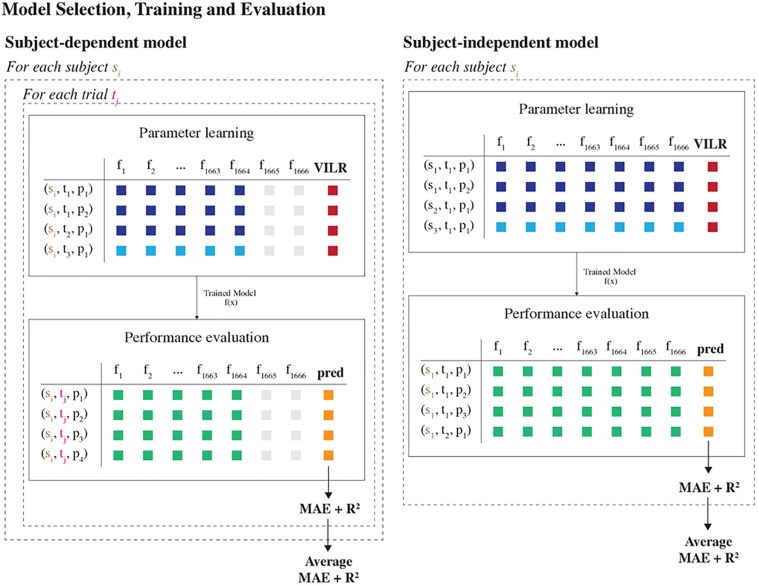
Model selection, training and evaluation part of the machine learning pipeline. Two different learning settings were considered, differing in how the data were split into training and test sets. In the subject-dependent setting, we trained a model on the data of one specific runner, including all trials except one. Subsequently, the model was evaluated on the data of the one held-aside trial. In the subject-independent setting, we trained a model on the data of all runners except for one and evaluated the model on all data of the one held-aside runner. This procedure was repeated for each trial and subject, such that we obtained performance metrics for each fold. Last, the average MAE and R2 score per subject were reported.